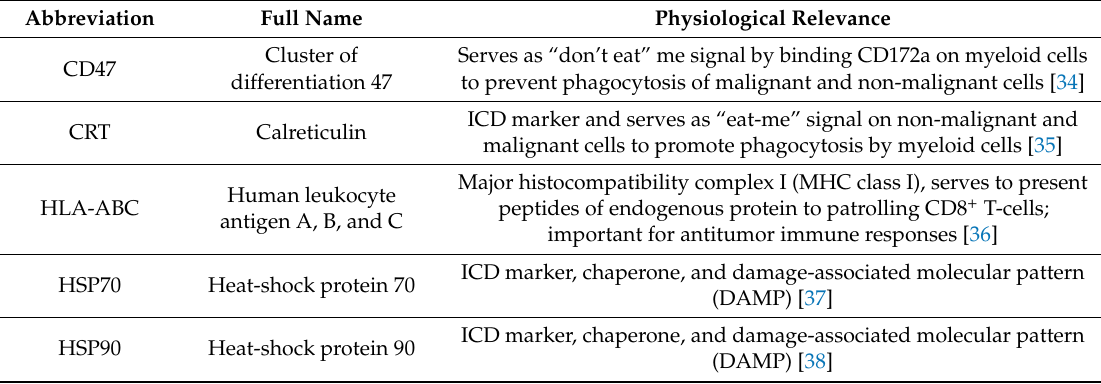
Table 1. Immunogenic cancer cell death (ICD)-related surface molecules investigated in this